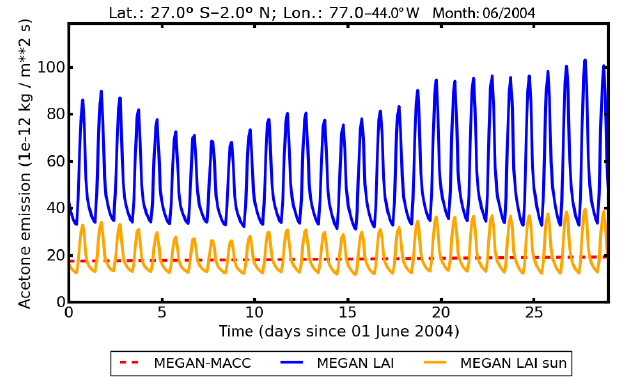
Figure 7. Acetone emission comparison of MEGAN-MACC (red dashed), MEGAN-Online LAI (blue) and MEGAN-Online LAI sun (orange) averaged over South America (77 to 44 ◦ W and 27 ◦ S to 2 ◦ N) in June